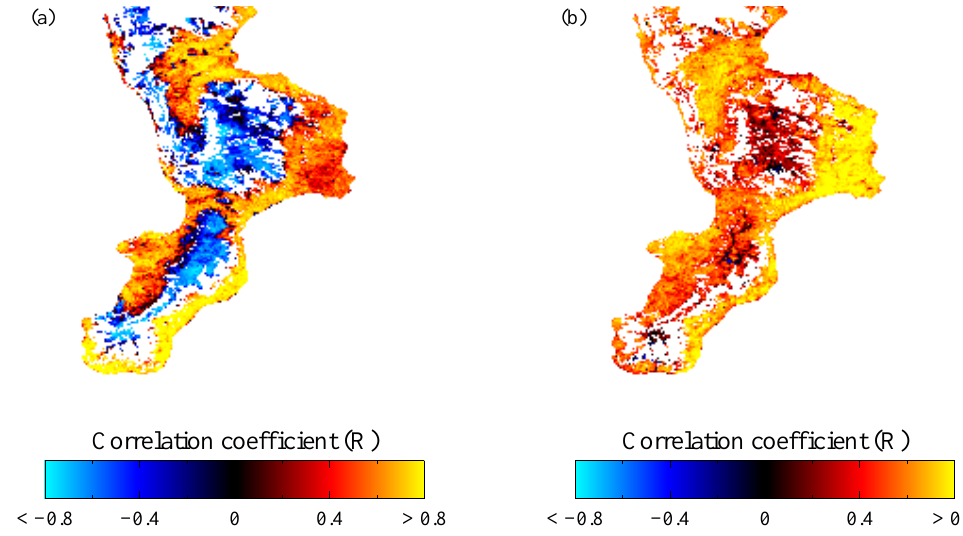
Fig. 7. Correlation coefficients between modelled soil moisture averaged over 16 days and 16-day NDVI (a) and modelled soil moisture and ASAR soil moisture (b) , for each pixel of the study site for the 3-yr time series.